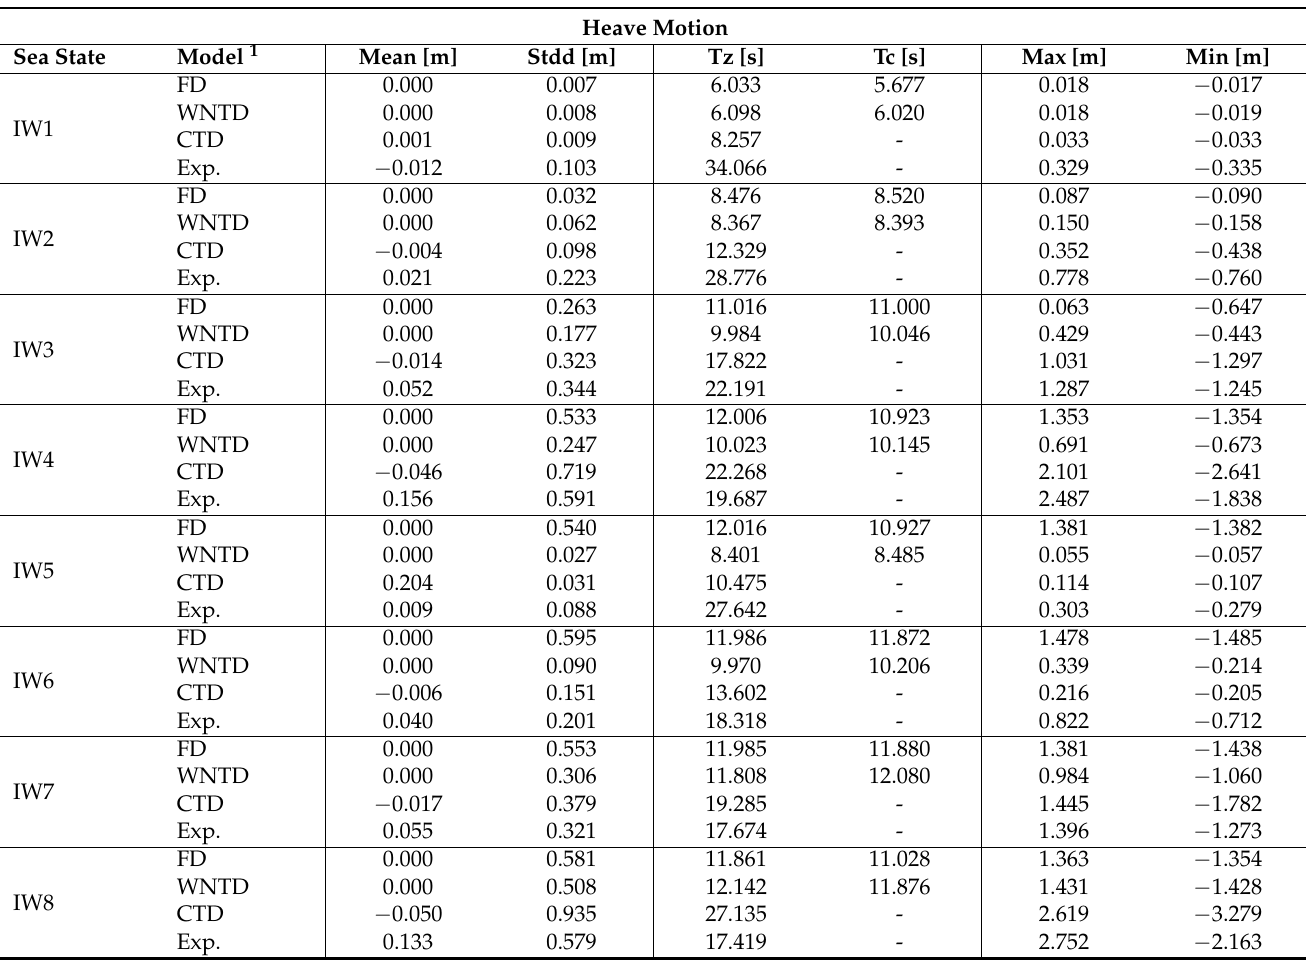
Table 7. Heave motion statistics in irregular wave conditions according to different methods. Heave